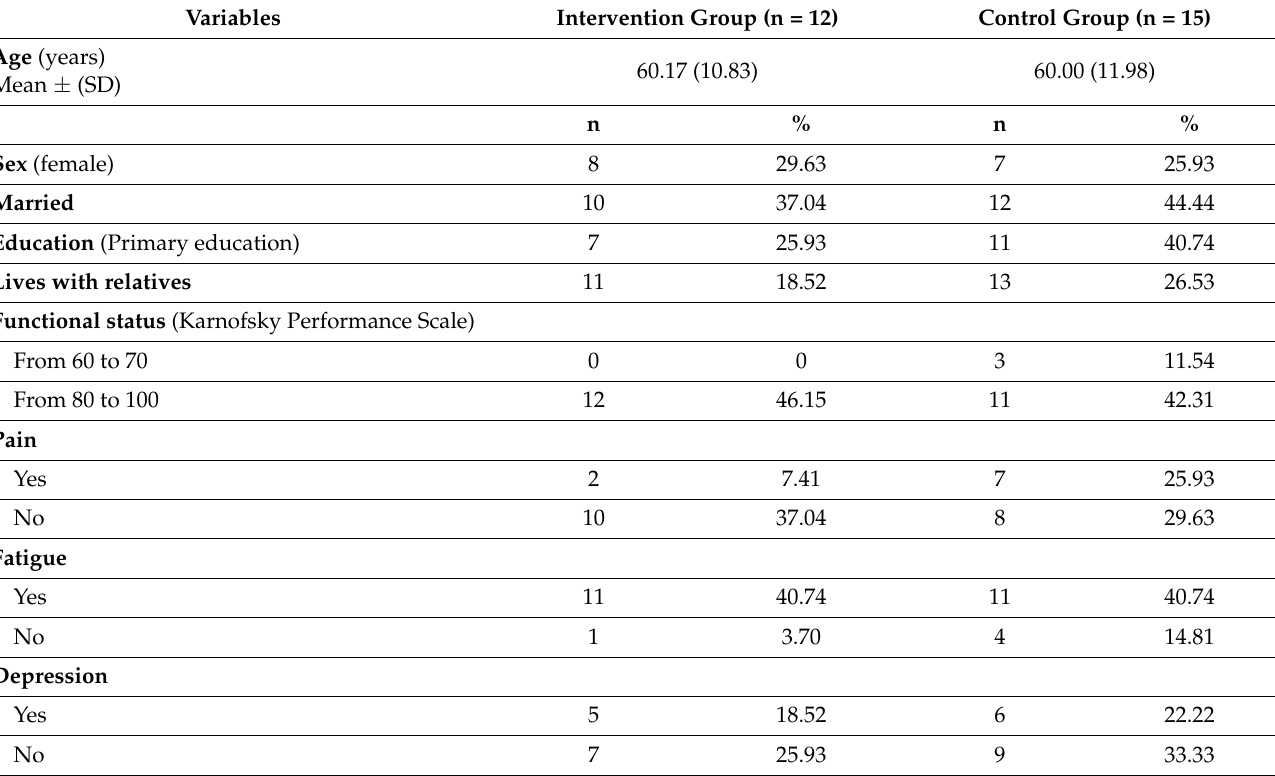
Table 2. Participants’ baseline